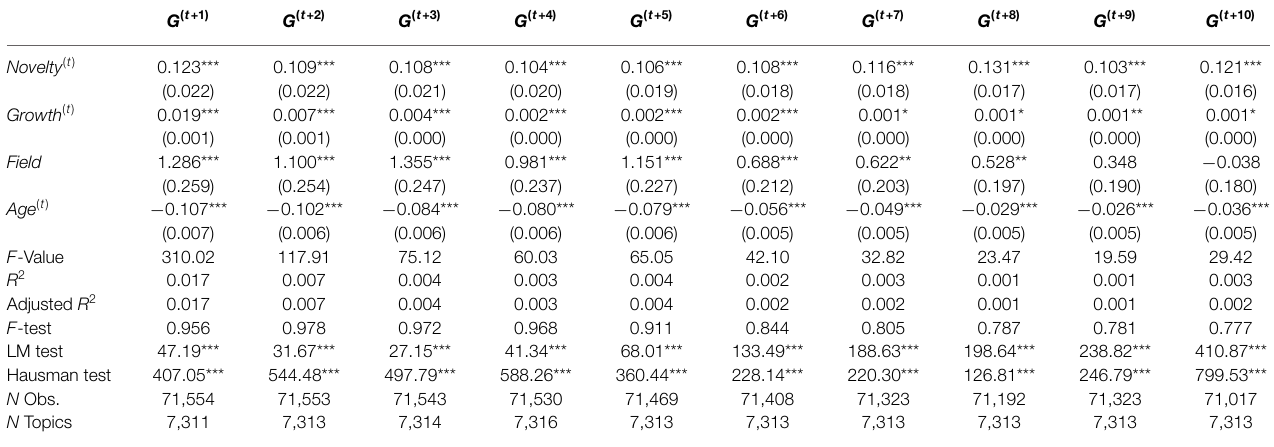
TABLE 3 | Growth ( t + ∆ t ) random-effect models